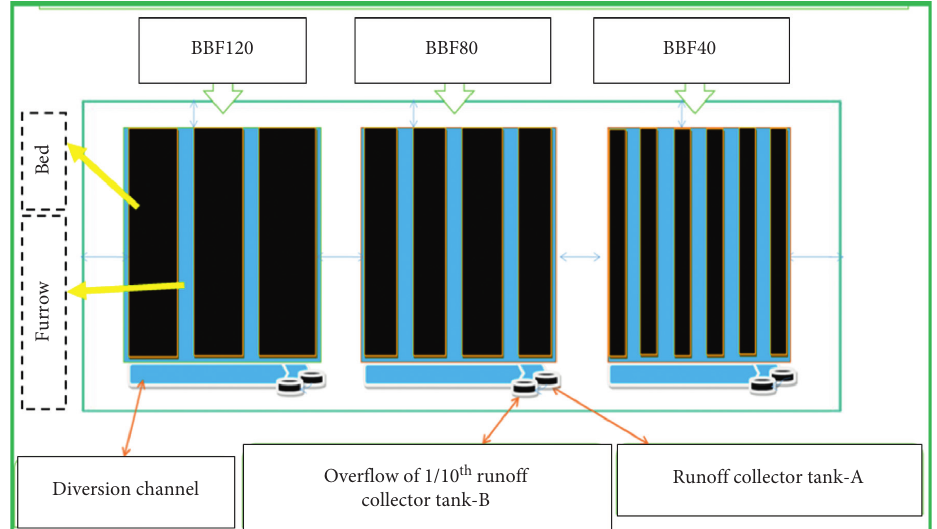
Figure 2: Field layout of the experiment.